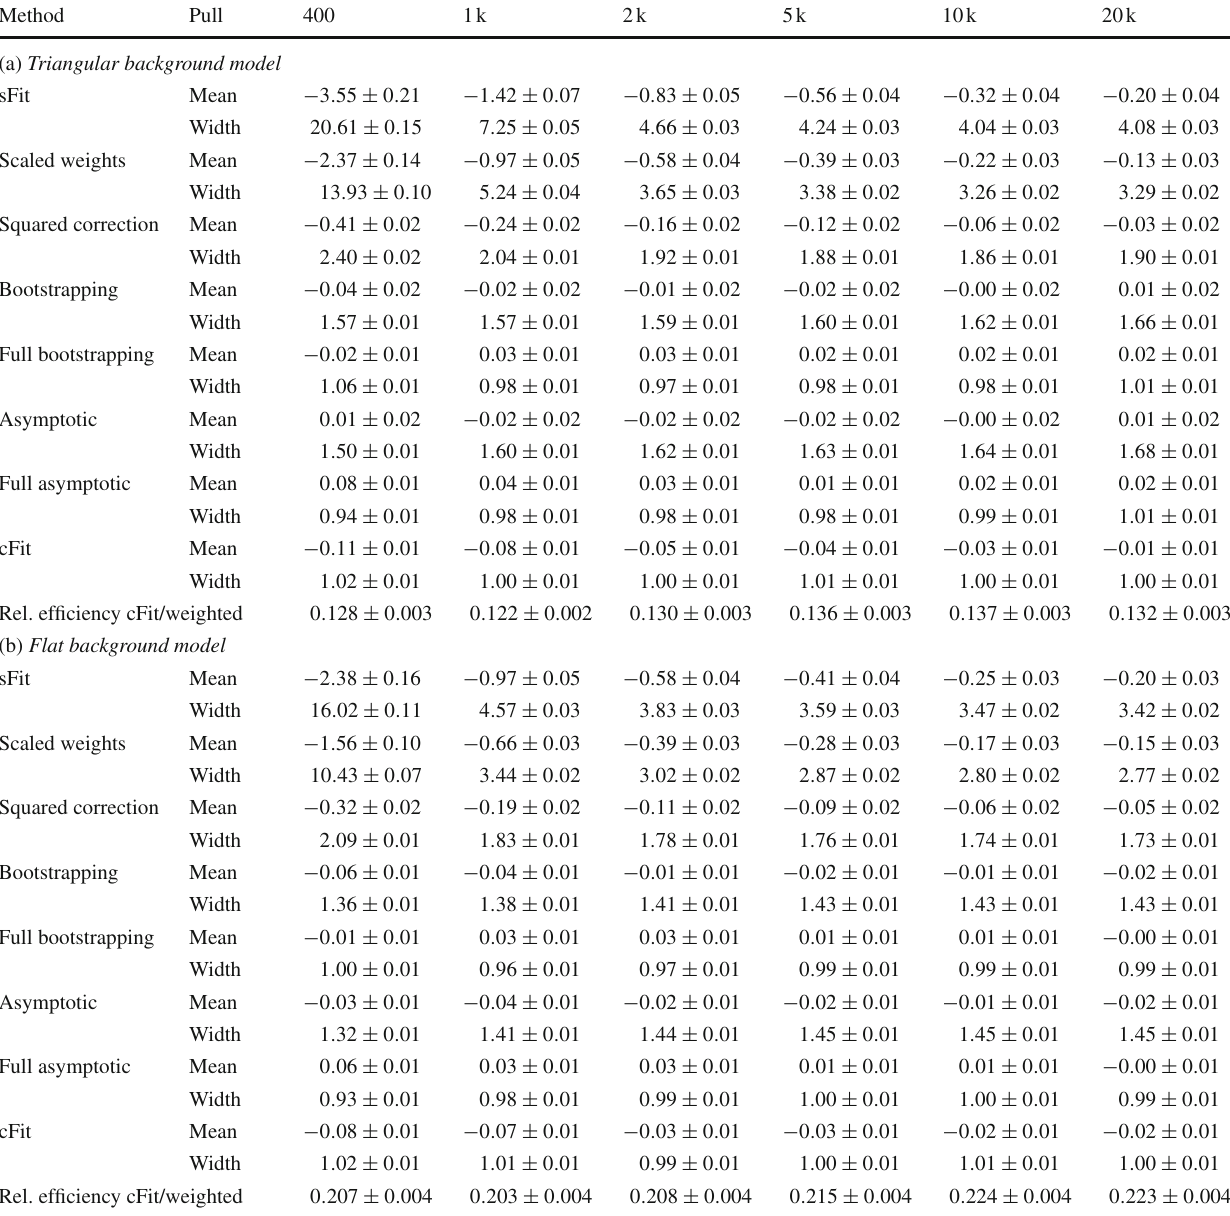
thecFitestimatorandtheweightedestimatordefinedbyEq. 3aregiven. Thedifferenttablesshowncorrespondtothedifferentbackgroundmod- els as specified in Sect.